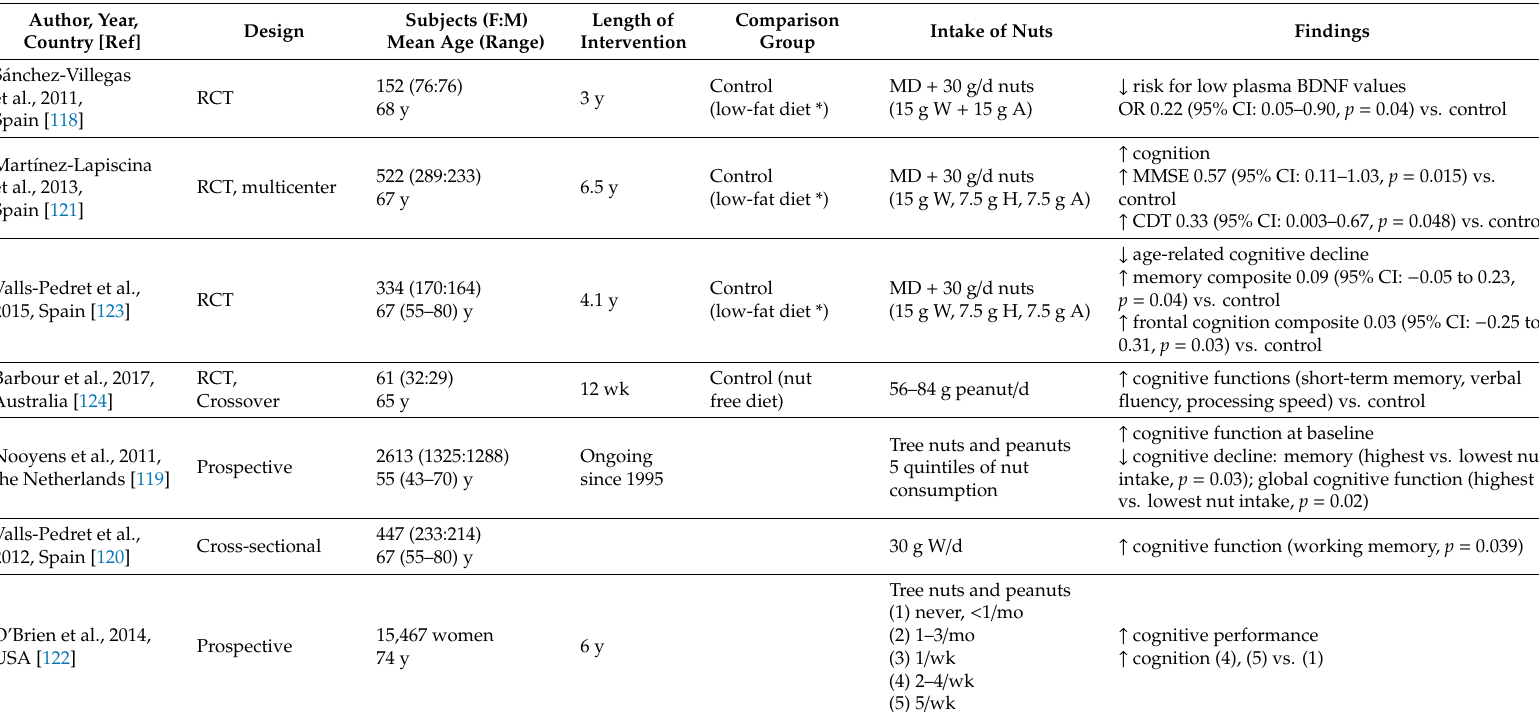
Table 6. Association between nut consumption and cognitive